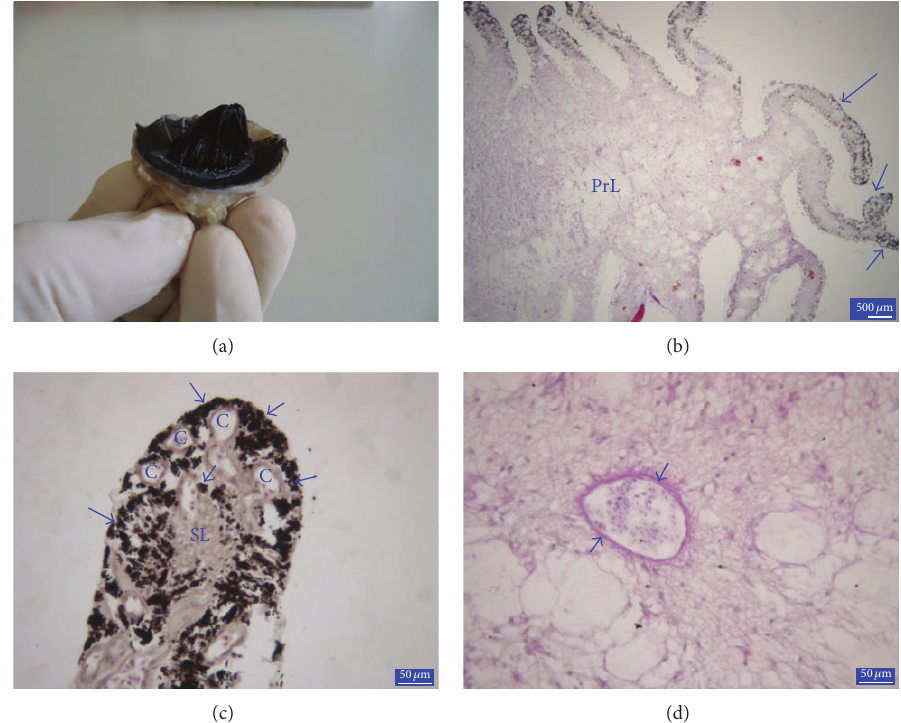
Figure 3: The appearance of pecten oculi of the ostrich (a). Paraffin sections from the ostrich pecten oculi (b, c, and d). PrL: Primary lamellae, large arrows: secondary lamellae, small arrows: tertiary lamellae, Crossmon’s trichrome stain (b). SL: secondary lamellae, C: blood capillaries, arrows: pigmentation, Crossmon’s trichrome stain (c). Arrows: thick basement membrane, PAS (d).